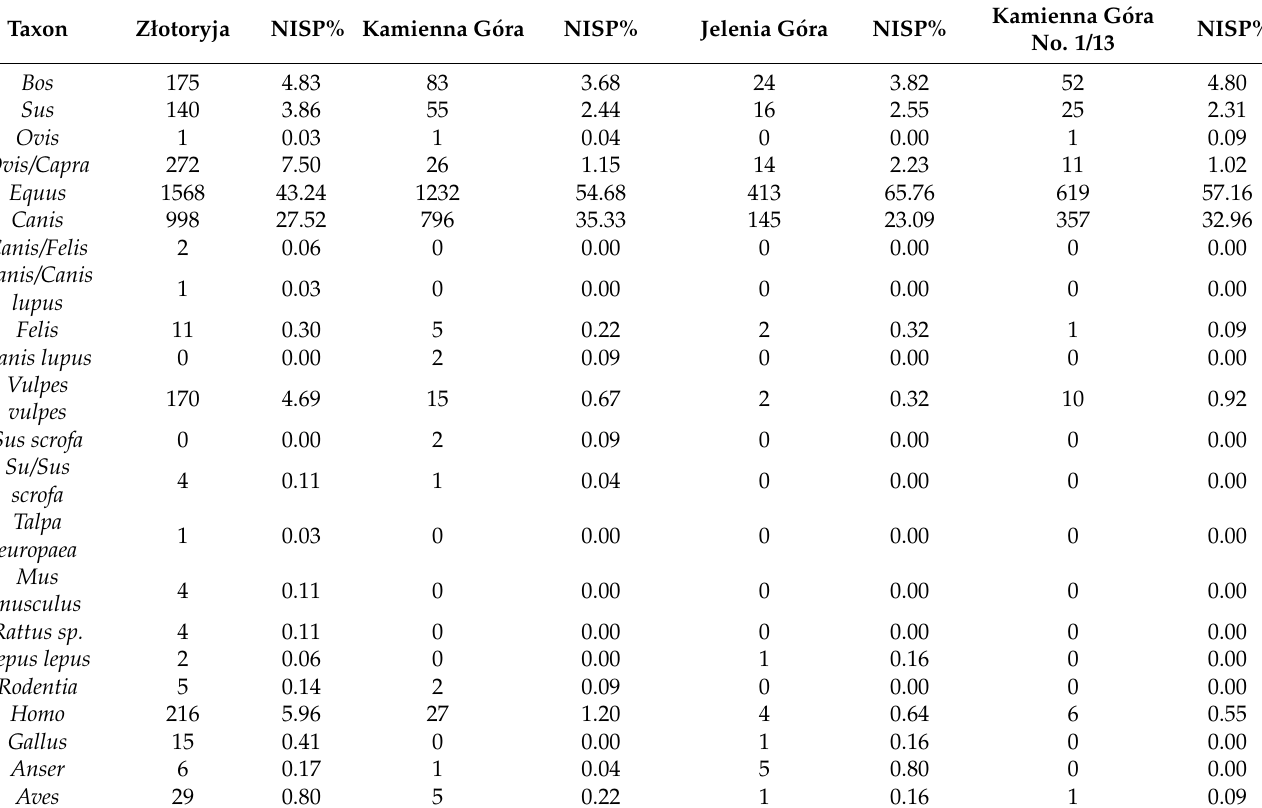
Figure 2. Incomplete domestic cat skeleton unearthed at Złoty Stok gallows site as the example of only discovery that was accessible for archaeozoological analysis. Table 2. Frequency of taxa in NISP, archaeological site at Złotoryja, Kamienna G ó ra and Jelenia G ó ra. Bos , cattle; Sus , swine; Ovis , sheep; Ovis / Capra , sheep/goat group; Equus , horse; Canis , dog; Canis / Felis , dog/cat group; Canis / Canis lupus dog/wolf group; Felis , cat; Canis lupus , wolf; Vulpes , fox; Sus scrofa , wild boar; Sus / Sus scrofa , swine/wild boar group; Talpa , mole; Mus , mouse; Rattus sp. , rat; Lepus , hare; Rodentia , rodents; Homo , human; Gallus , hen; Anser , goose; Aves , birds; Corvus , crow; Gastropoda , snail. Kamienna G ó ra no. 1/13 present the NISP estimated in skeletal material from the complete animal-catcher waste pit unearthed within the Kamienna G ó ra gallows